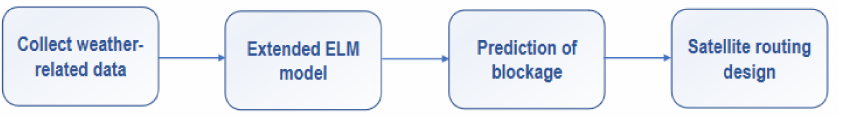
Figure 5. Overall process of the